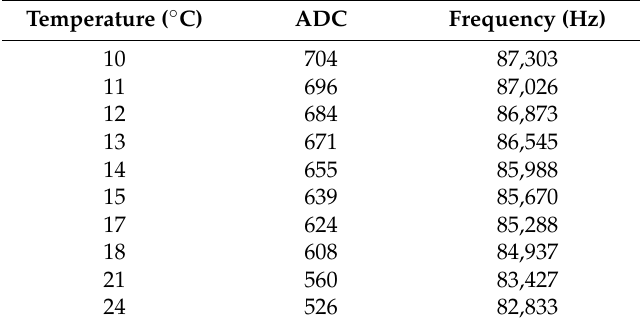
Table 1. The probe’s readings at different temperatures.